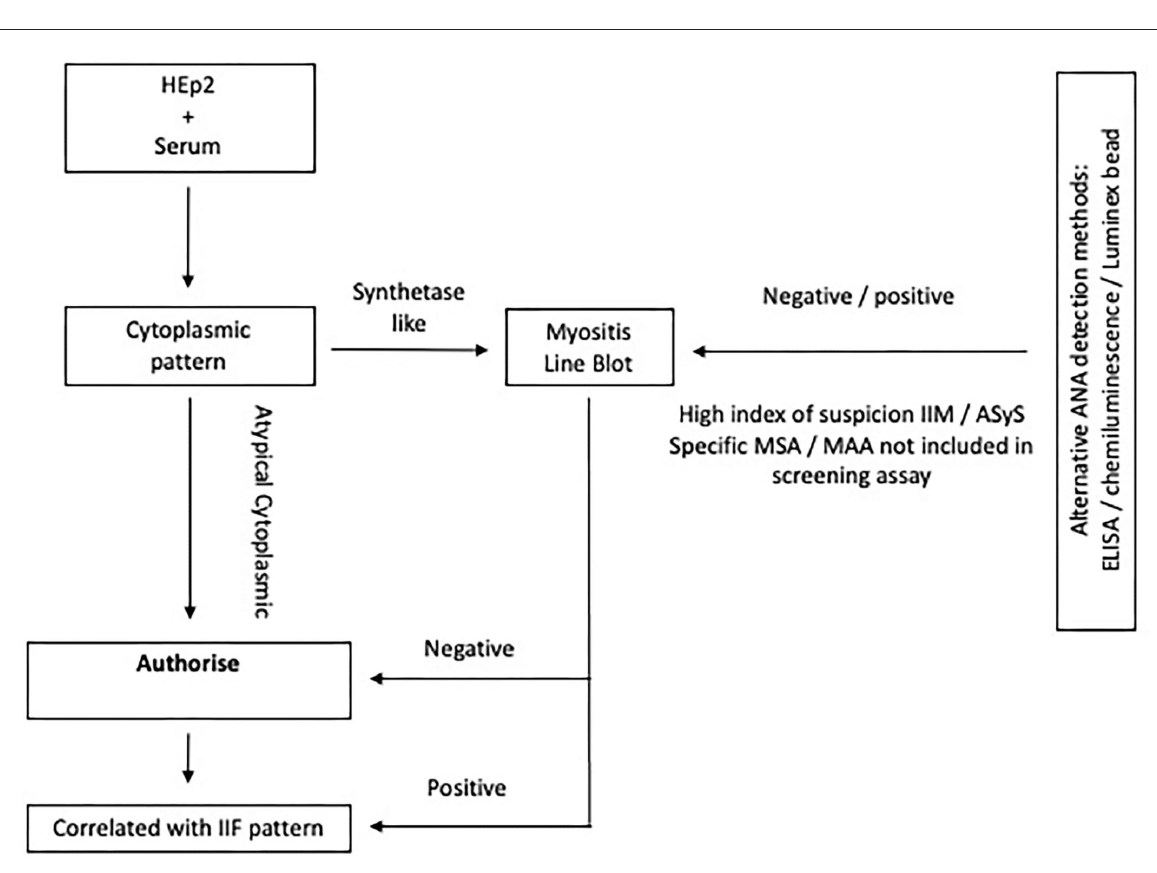
FIGURE5 Algorithm depicting ANA assaying in ASyS. Extended testing is advised in the context of a cytoplasmic pattern on IF. If alternative ANA screening methods are used and suspicion of ASyS or IIM remains high, it may be appropriate to perform extended testing, especially when certain potentially relevant MSA or MAA are not included in the screening antigen profile and there are cutaneous, pulmonary, or vascular features of